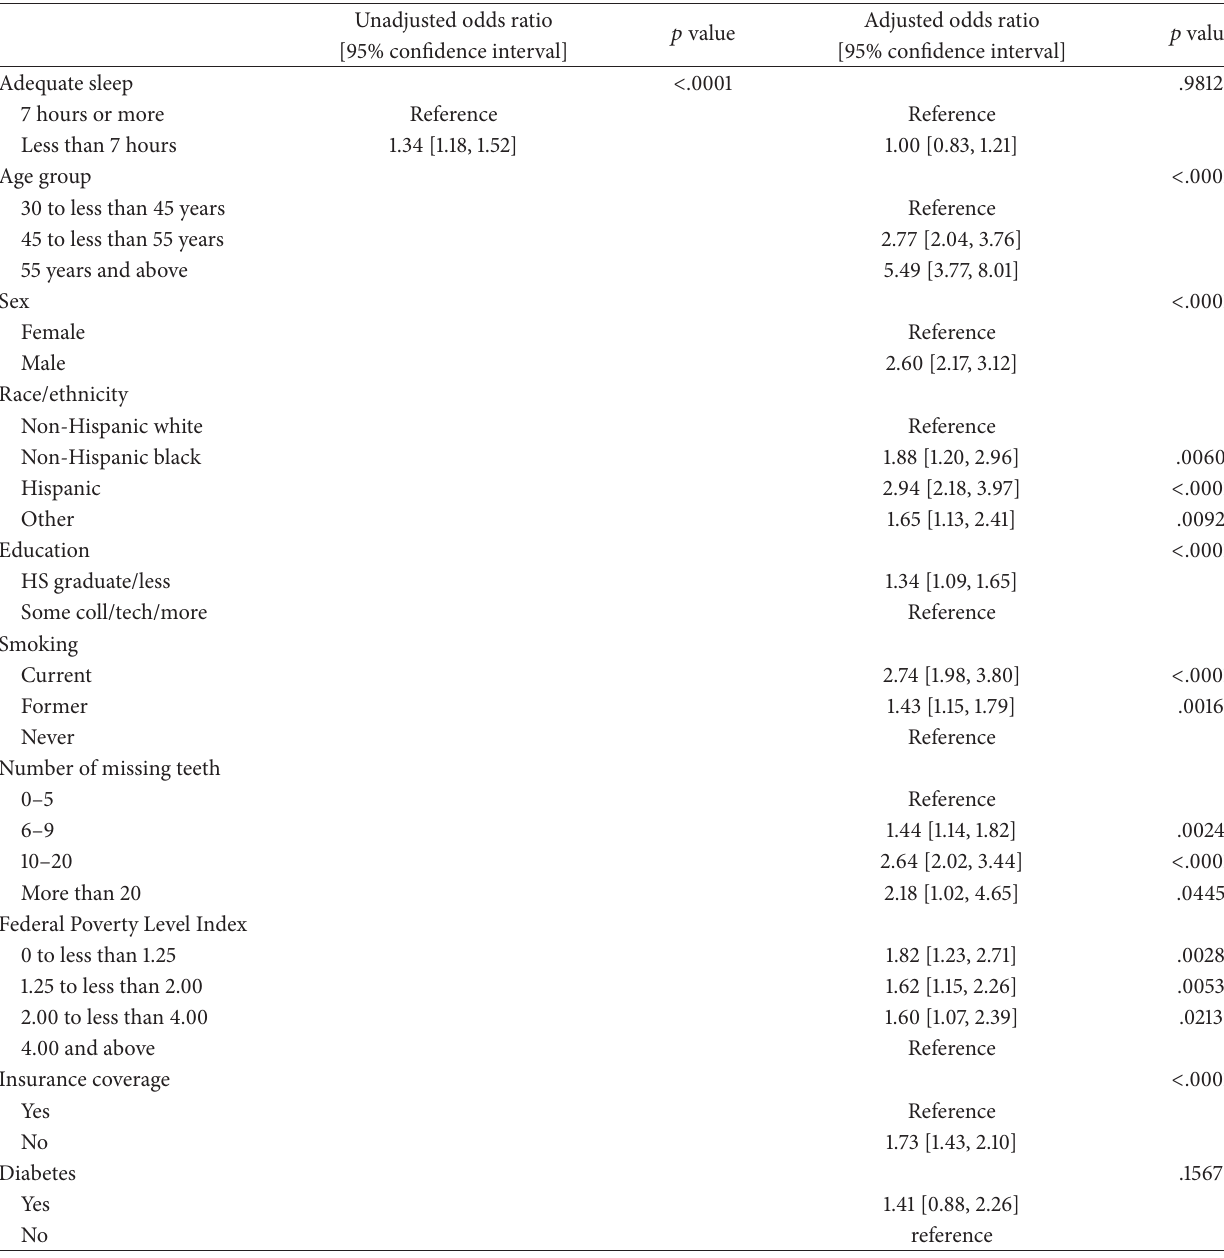
Table 3: Logistic regressions of adequate sleep on periodontitis, NHANES